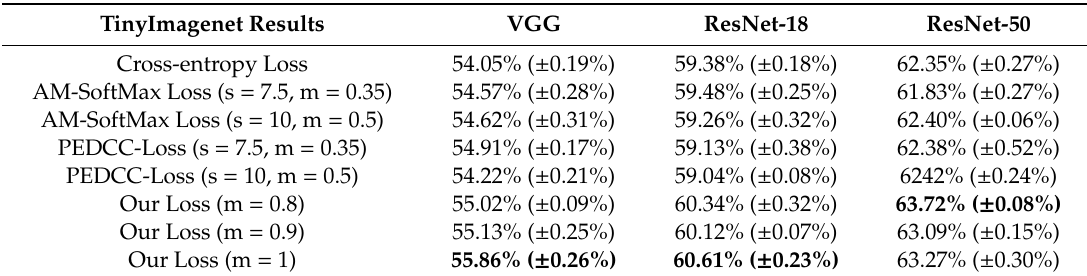
Table 2. The experimental results of TinyImagenet dataset.